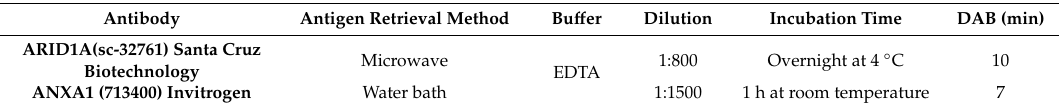
Table 1. Adenine thymine-rich interactive domain 1A (ARID1A) and annexin A1 (ANXA1) primary antibodies used in immunohistochemistry (IHC) and conditions. Antibody Antigen Retrieval Method Bu ff er Dilution Incubation Time DAB (min) Microwave 1:800 ANXA1 (713400) Invitrogen 1:1500